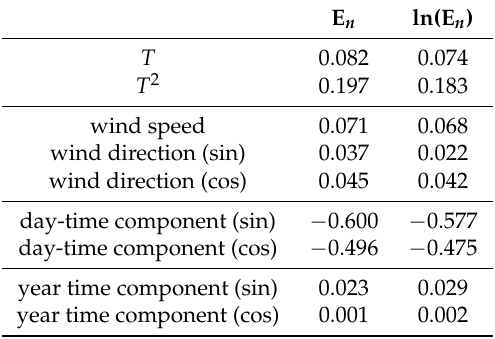
Table 1. Pearson correlation coefficients between all features and the methane emission E n , respectively the logarithm of the emission ln(E n ), as target. Here, T refers to the ambient air temperature close to the building. Wind speed and wind direction were monitored by an anemometer on the